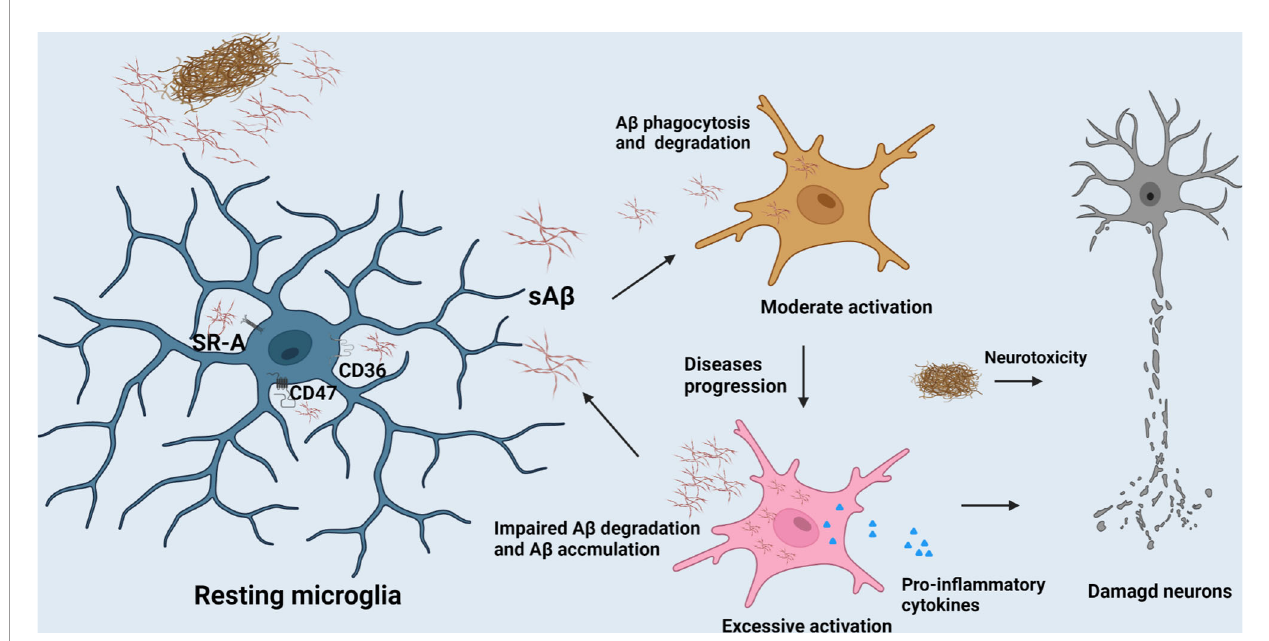
FIGURE 1 | The role of microglia in AD progression. The clearance of A b mediated by microglia contributes to the homeostasis maintenance of CNS. But, with the AD progression, excessive activation of microglia would release excessive pro-in fl ammatory factors to compromise neurons and their